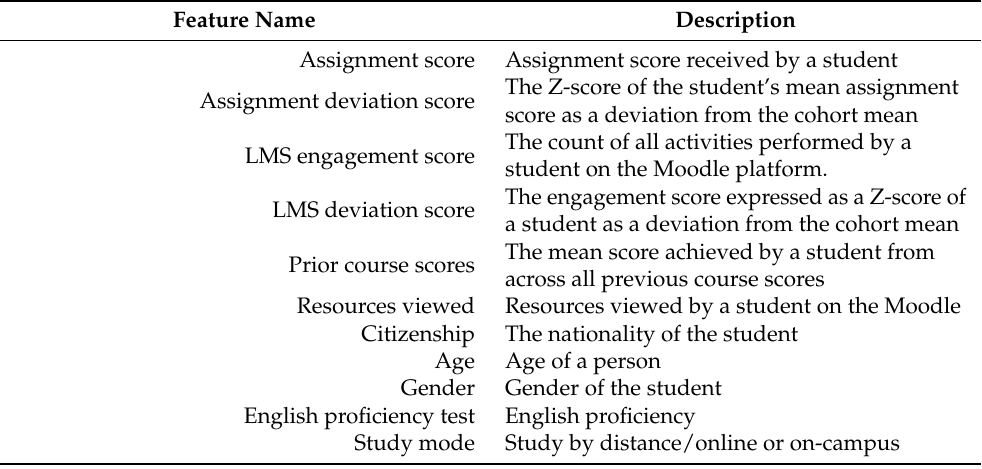
Table 1. Feature